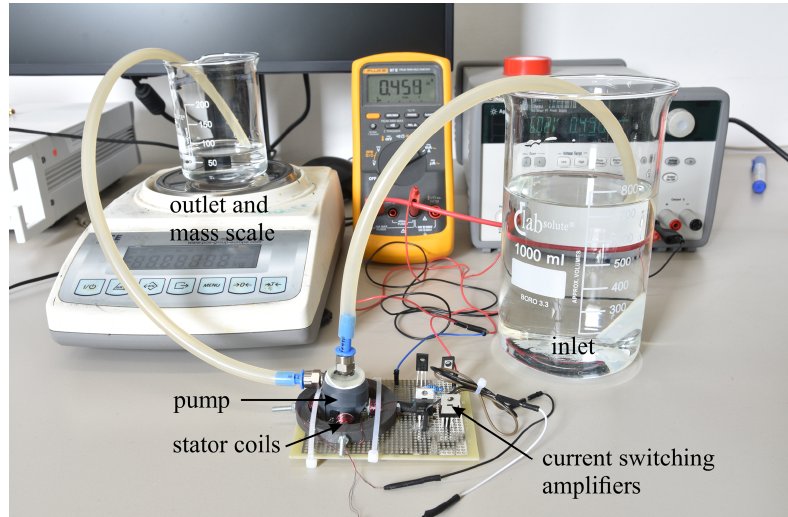
Figure 7. Photograph of experimental setup with printed, centrifugal pump placed inside stator coils on current switching circuit board (bottom center), board driven by laboratory power supply with applied current measured with a multimeter (back), inlet reservoir and outlet reservoir on similar liquid level to prevent hydrostatic flow, output flow measured with mass scale (left).